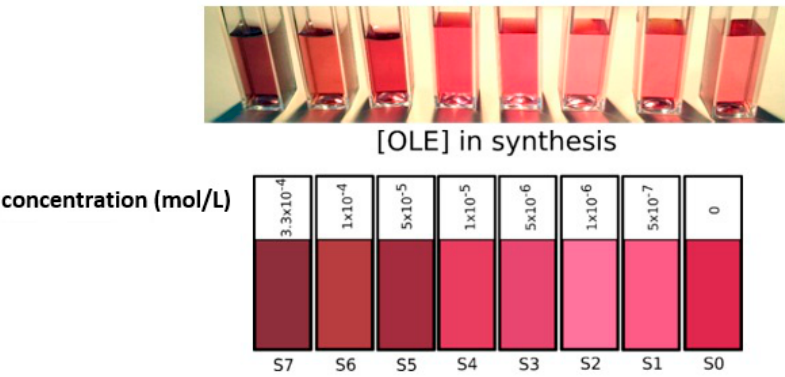
Figure 1. Photograph (upper) and RGB color simulation derived from absorbance spectra (lower) of all gold colloids obtained.